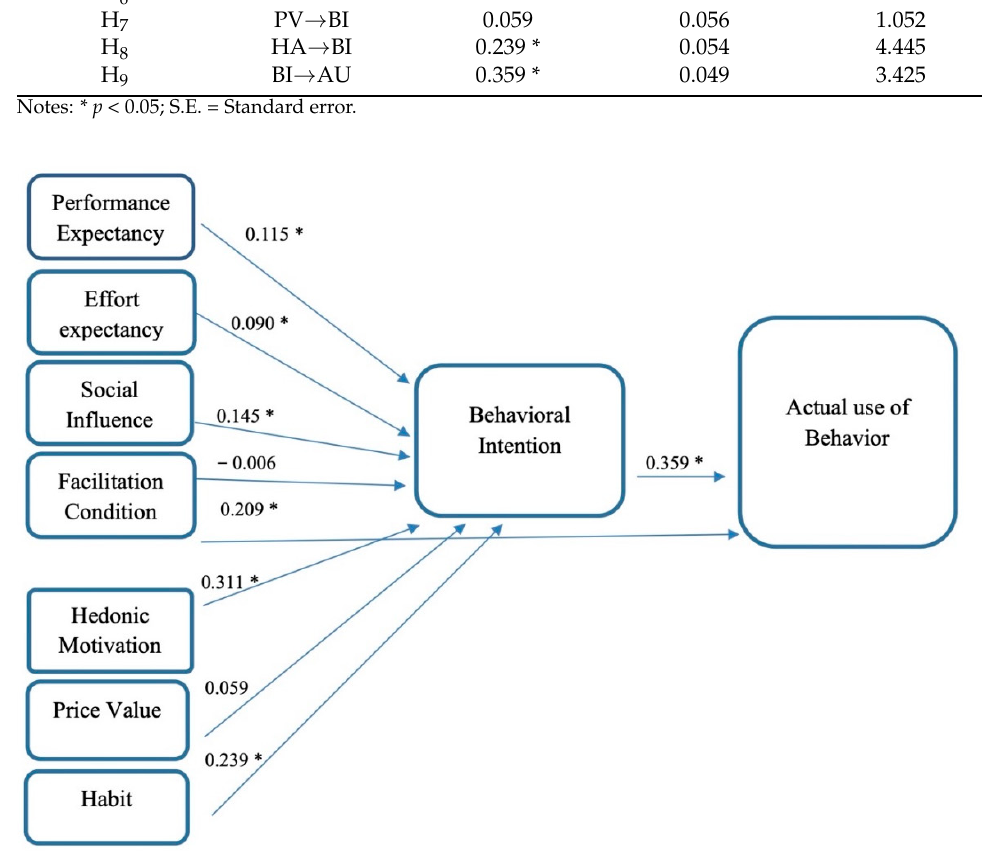
Figure 2. Results of Structural